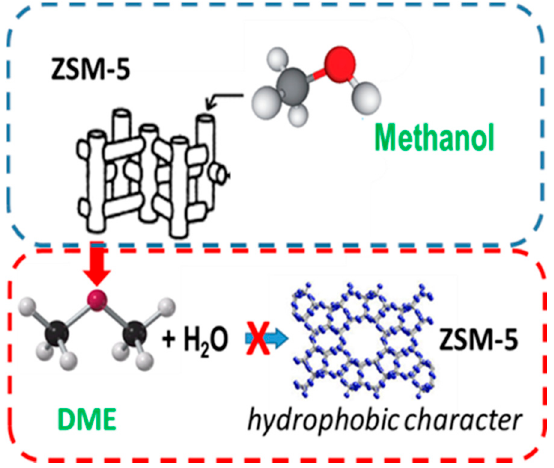
Figure 9. Schematic illustration of the methanol dehydration to DME on hydrophobic ZSM-5 zeolite.